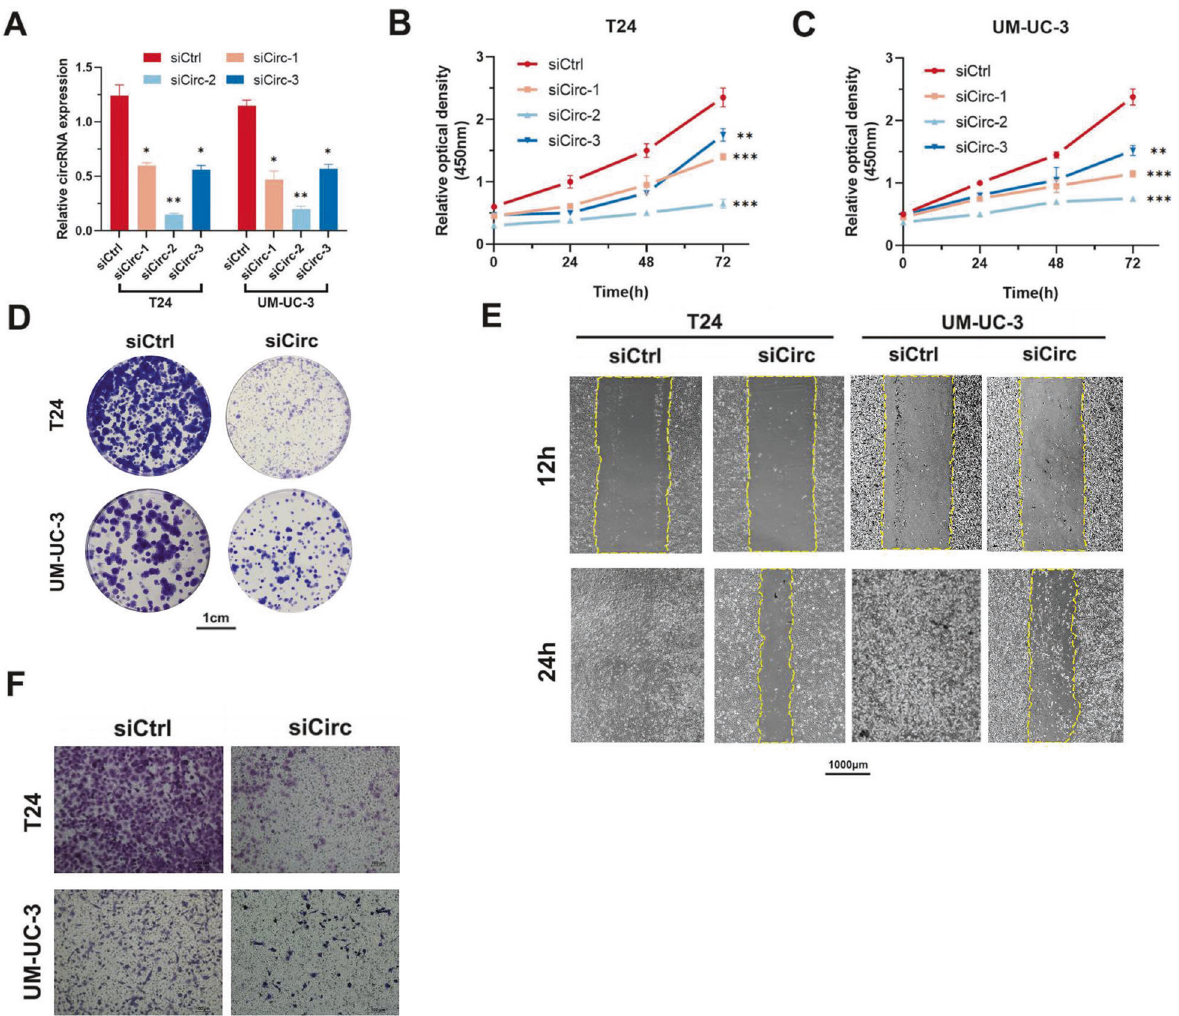
qRT-PCR ( N = 3, Kruskal – Wallis test). At 24 h after siRNA transfection, B , C CCK-8 assays ( N = 3, Kruskal – Wallis test) and D colony formation assays (scale bar represents 1 cm) were used to assess the proliferation ability of cells. E Wound healing assays (scale bar represents 1000 μ m) were used to assess the migration ability of cells. F Transwell assays (scale bar represents 100 μ m) were used to assess the invasiveness of cells. All error bars in the fi gures indicated the standard deviation of three independent experiments. * P < 0.05, ** P < 0.01, *** P <